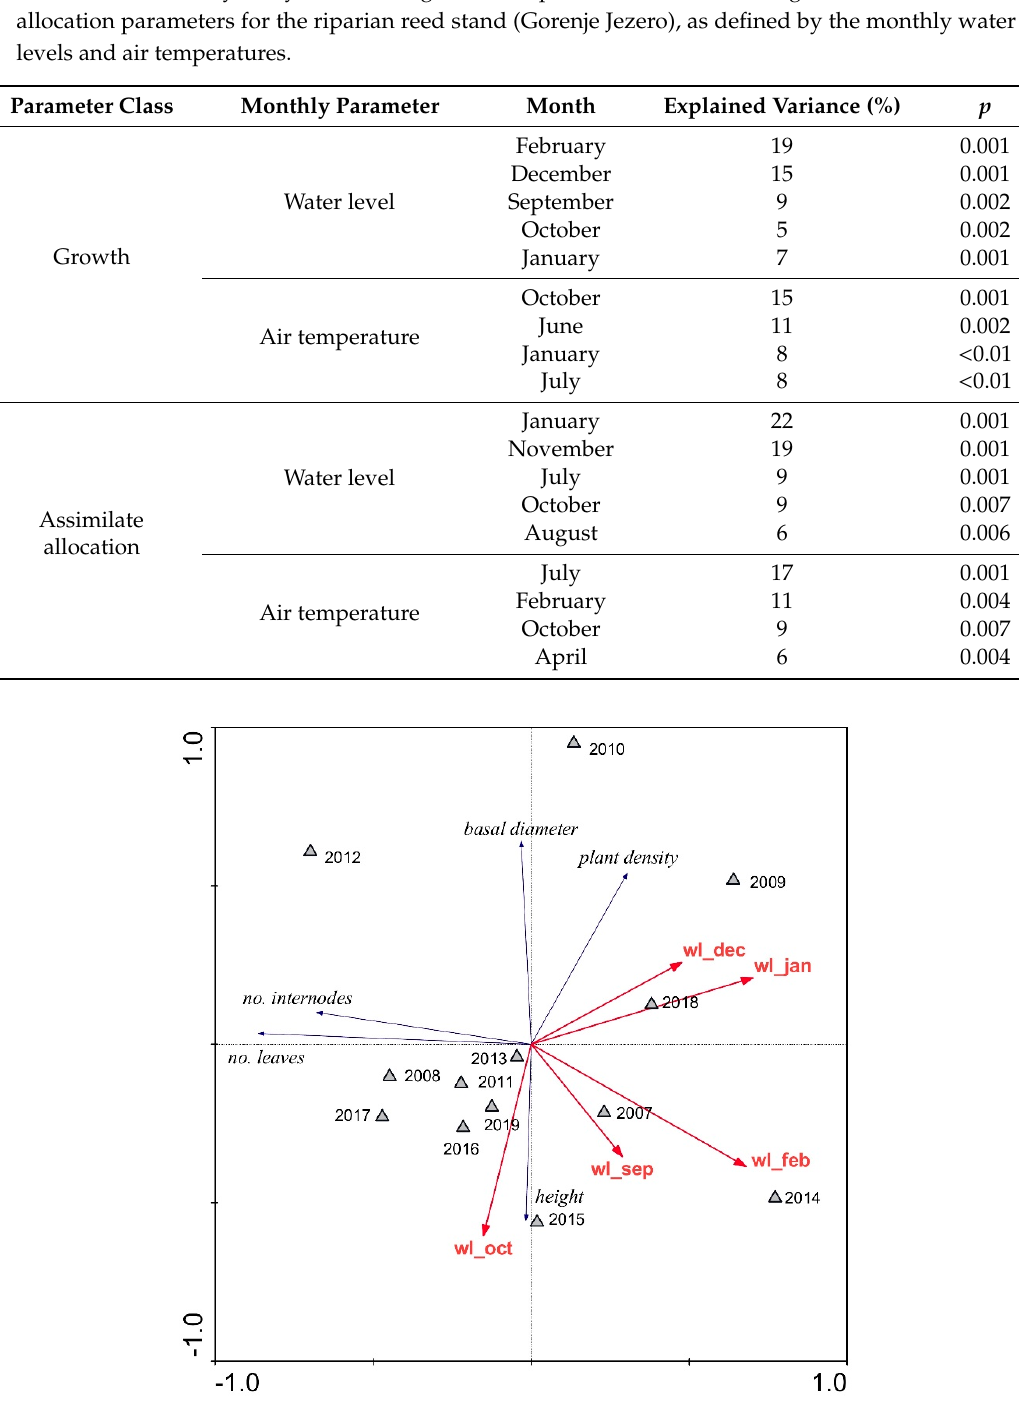
Figure 6. Redundancy analysis plot showing the strengths of the associations between monthly water levels and growth parameters of the common reed from the riparian stand (Gorenje Jezero). Triangles: different years; wl: water level; no.: number.